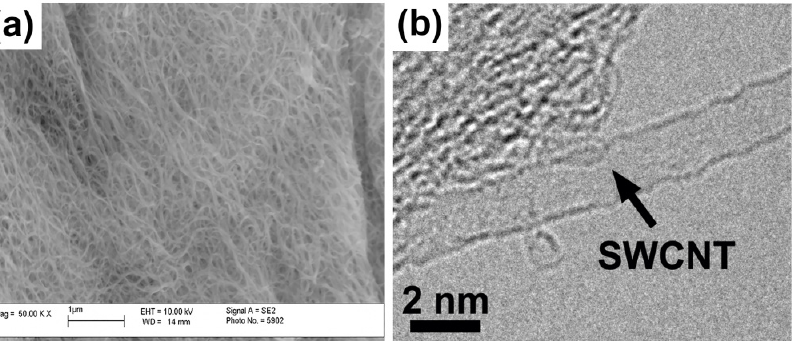
Figure 2. The SEM ( a ) (reprinted from [21], under the terms of the Creative Commons CC BY license) and TEM ( b ) images of the pristine SWCNTs (reprinted with permission from Springer, Applied Physics A, Kharlamova et al., Growth dynamics of inner tubes inside cobaltocene-filled single-walled carbon nanotubes) [22]. Copyright 2016).